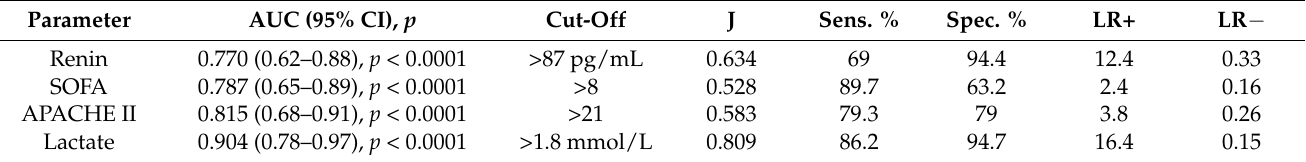
Table 3. Renin and other parameters determined on the first day as septic shock markers. Parameter